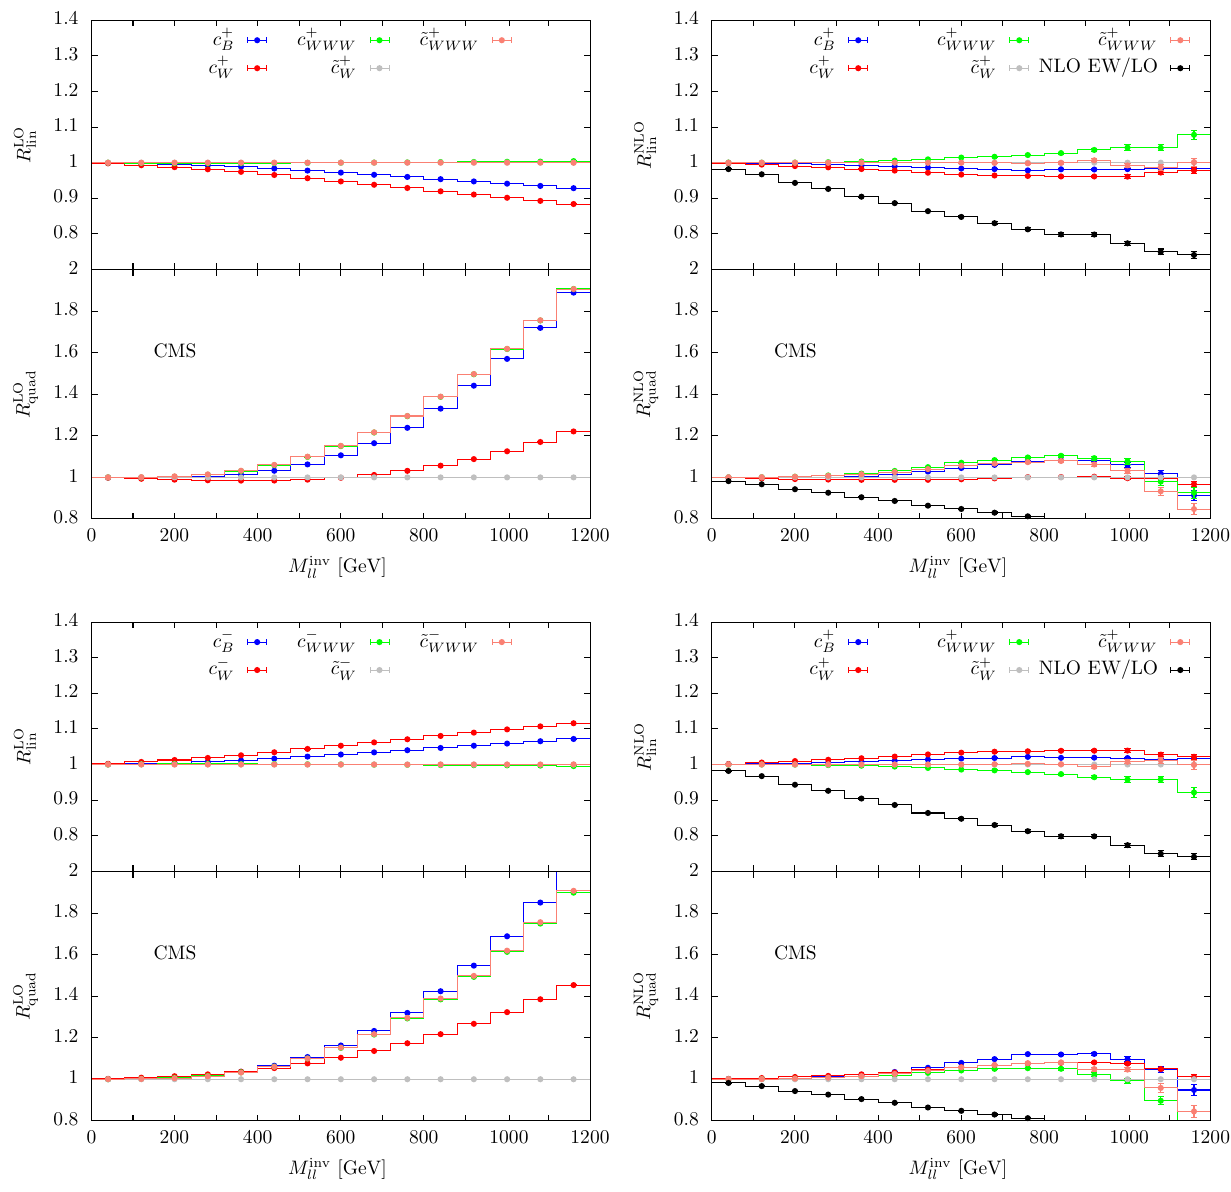
Fig. 8 Ratio R LO ( NLO ) as a function of the invariant mass of the charged-lepton pair for the process pp → e + ν e μ − ¯ ν μ in the CMS setup of Eq. (4.5). lin ( quad ) Same notation and conventions as in Fig.